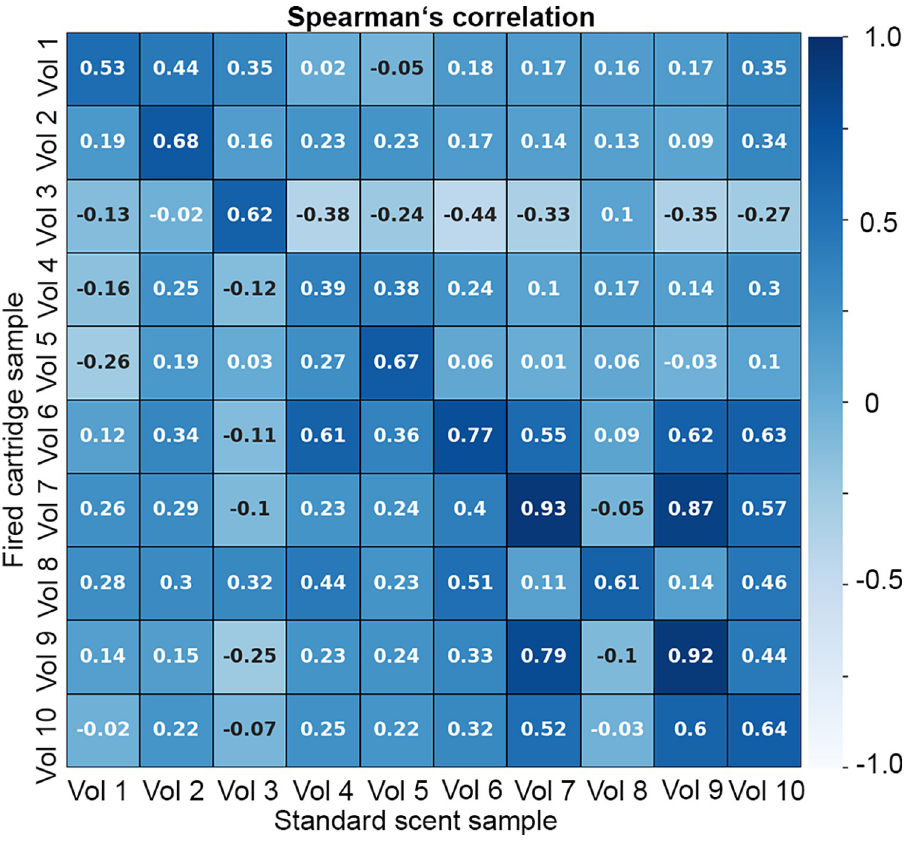
Fig 8. Graphical representation of the comparison between the standard scent samples and fired cartridge samples. The values correspond to the Spearman´s correlation score.